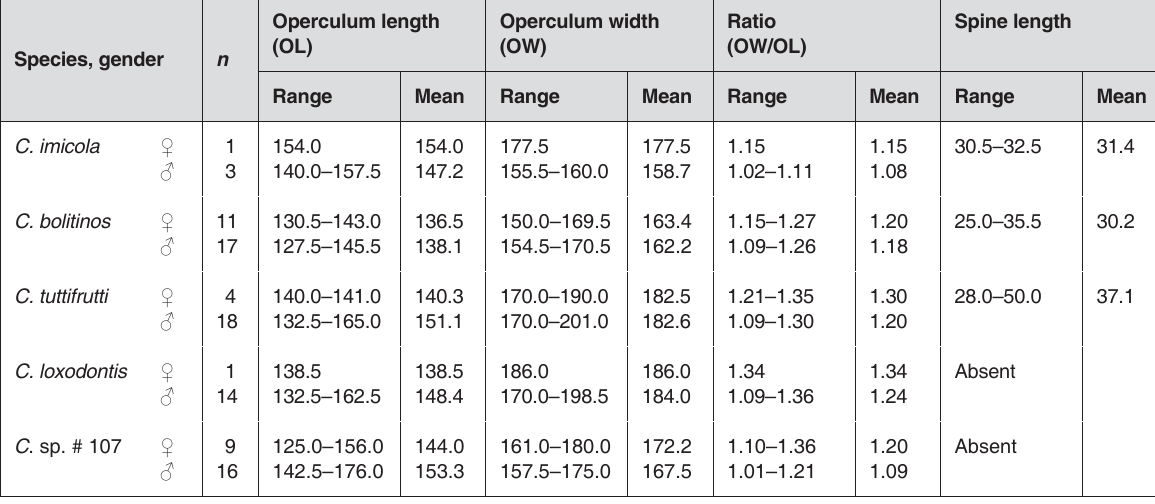
TABLE 3 Measurements ( μ m) of the opercular discs ( ♀♀ and ♂♂ ) and spine lengths ( μ m) of the pupae of five species of Culicoides of the Imicola complex